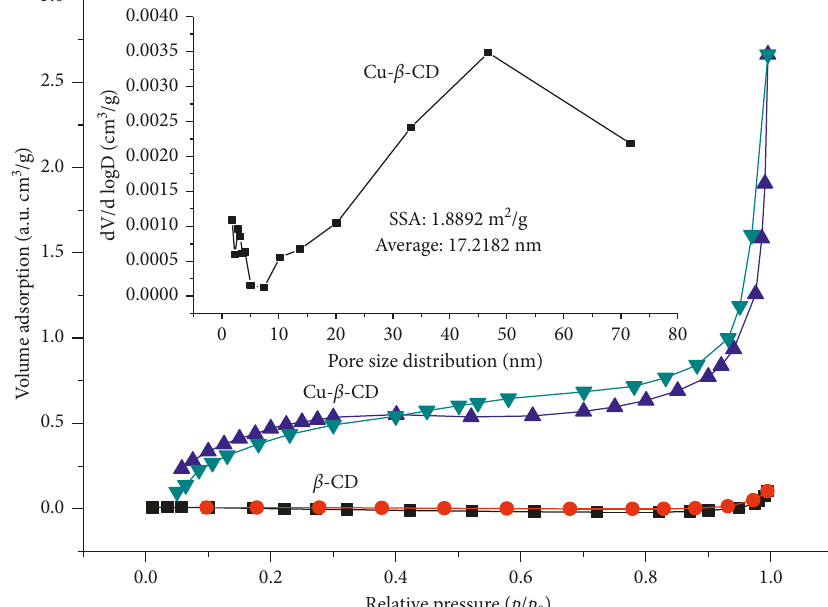
Figure 3: N 2 adsorption-desorption isotherms and pore size distribution of β -CD and Cu- β -CD.